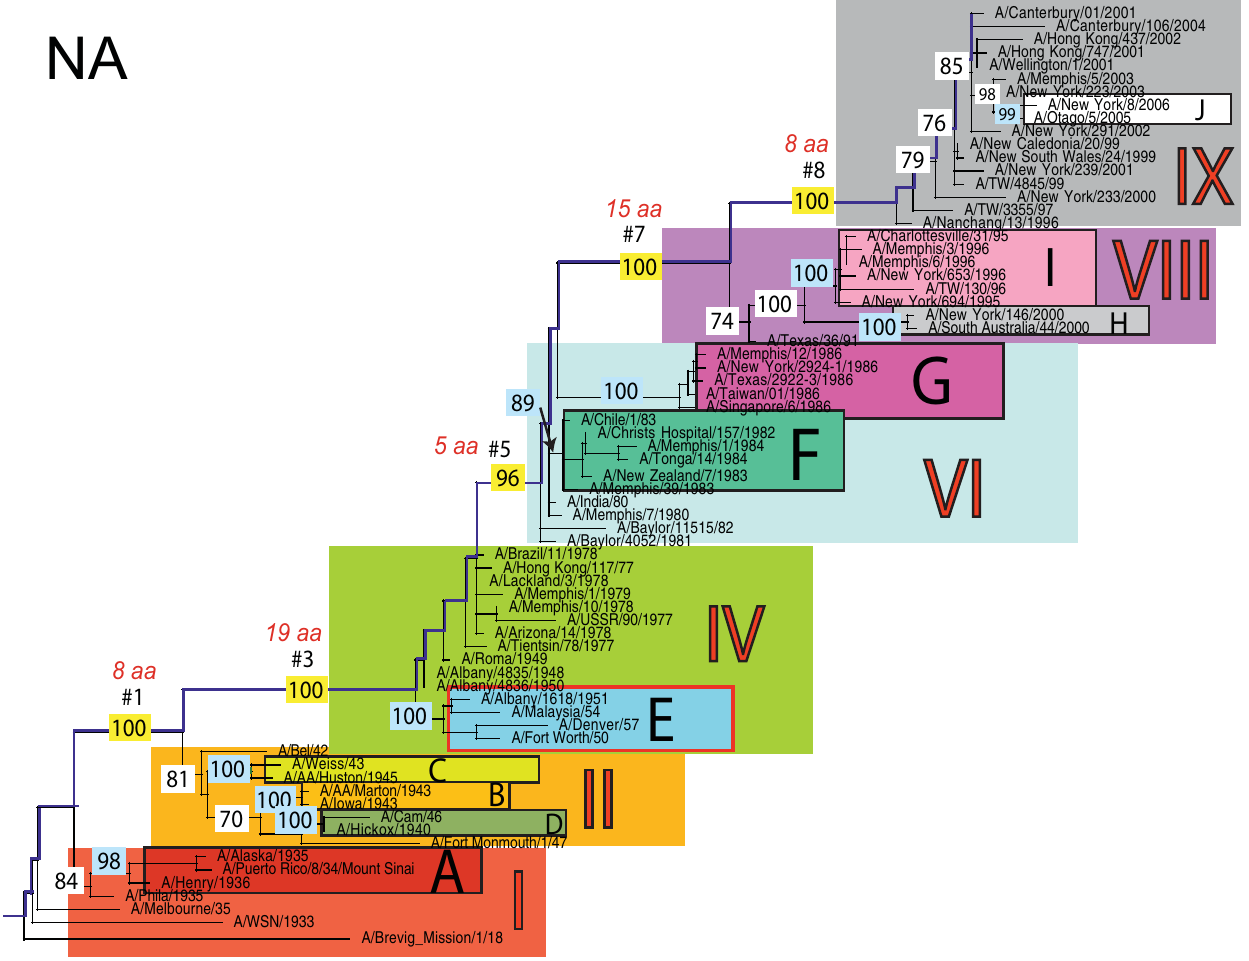
Figure 6. Phylogenetic relationships of the NA gene of A/H1N1 influenza viruses (n=71) sampled globally from 1918–2006, estimated using ML. Rooting, scale, and color scheme are the same as those used in Figure